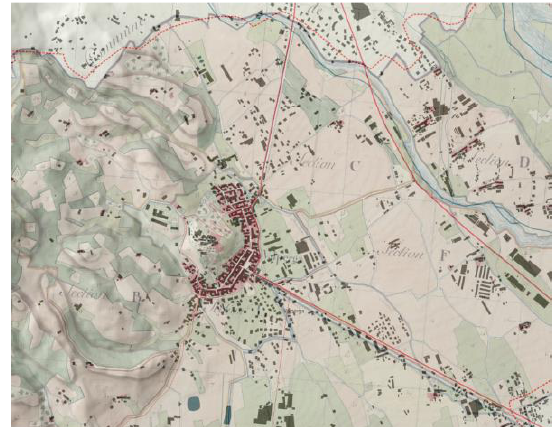
Figure 7. The sheet of Cadastral France map concerning the Valperga municipality (a multi parameters transformation